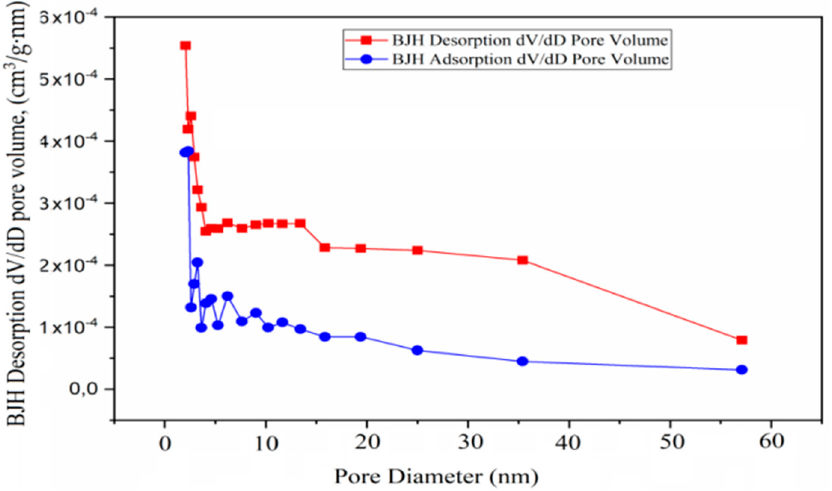
Figure 14. BJH adsorption and desorption of Ni/Al 2 O 4 catalyst pore volume.